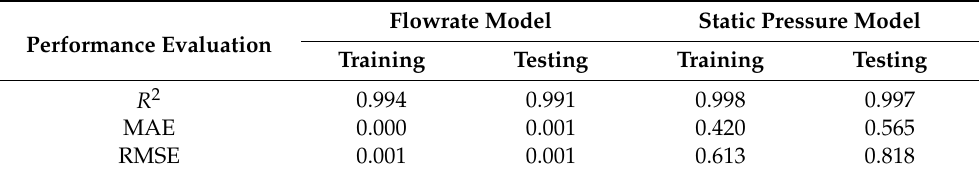
Figure 9. Scatterplot of the static pressure prediction model using ( a ) training data and ( b ) testing data. Table 6. Performance evaluation of flowrate and static pressure models.